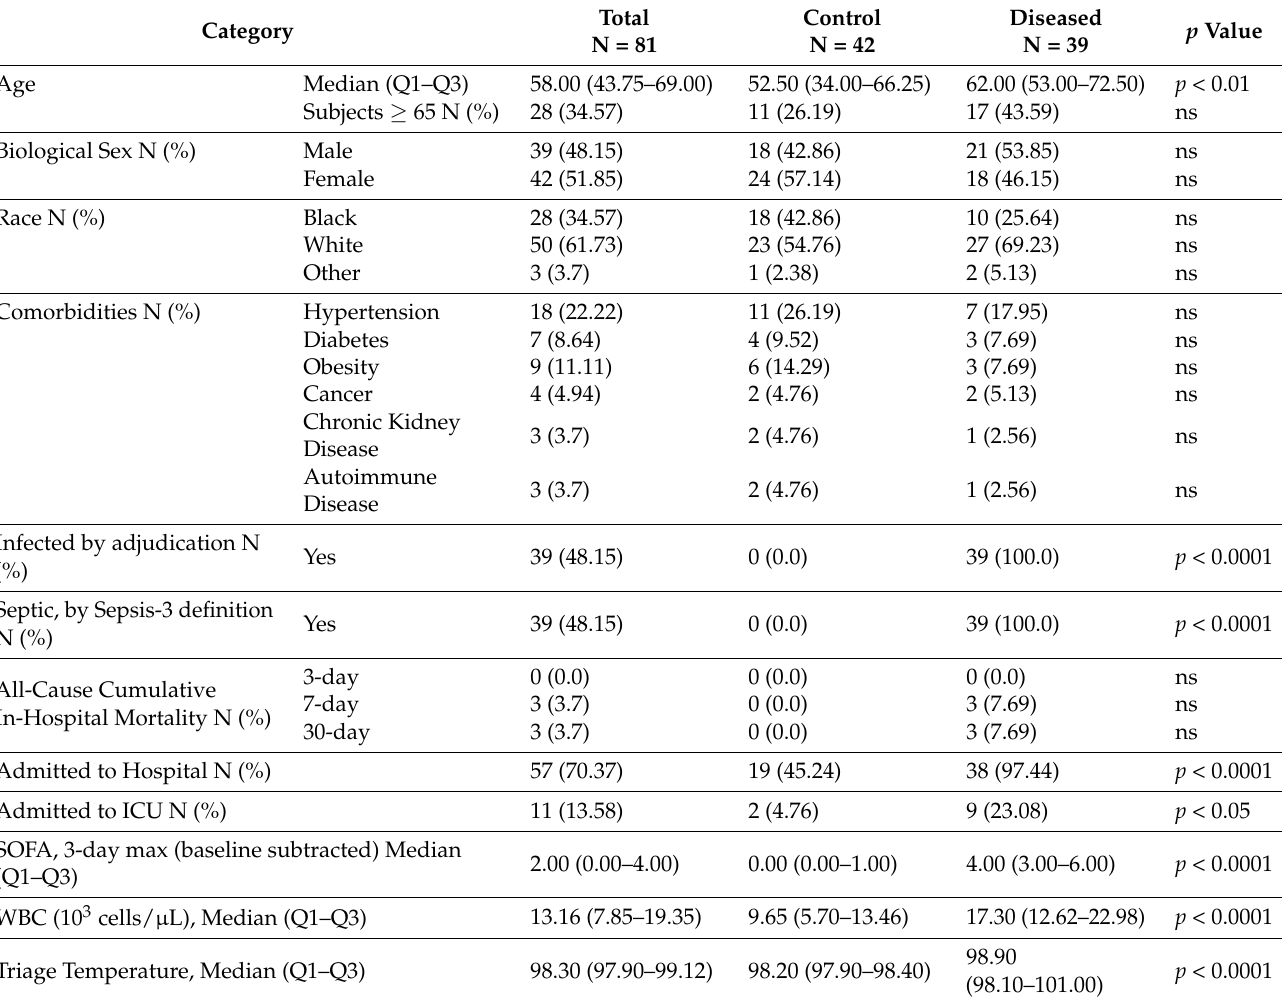
Figure 3. Quantity of neutrophil elastase (NE)-DNA, citrullinated histone H3 (Cit-H3)-DNA, and IntelliSep Index (ISI) for Control and Diseased patient plasma samples. * indicates p < 0.05 and ***** indicates p < 10 − 5 . Table 1. Summary statistics on demographics and outcomes of subjects. p -values were computed using a two-sided t-test.